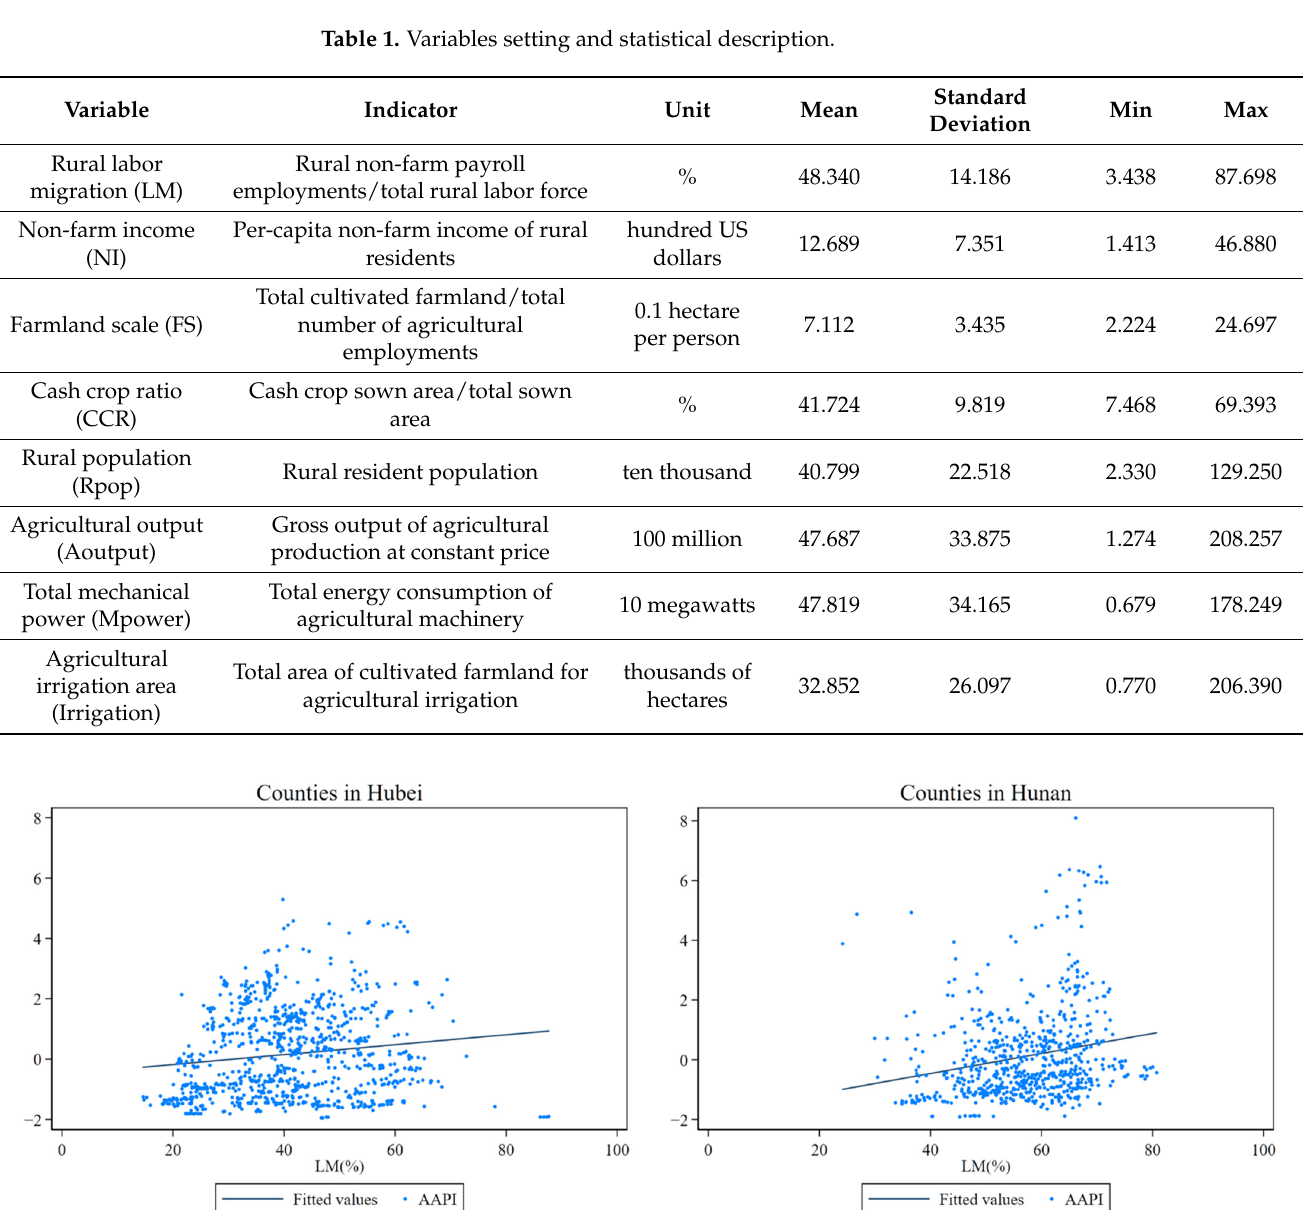
Figure 1. AAPI and rural labor migration (LM, %) of counties in Hubei and Hunan.